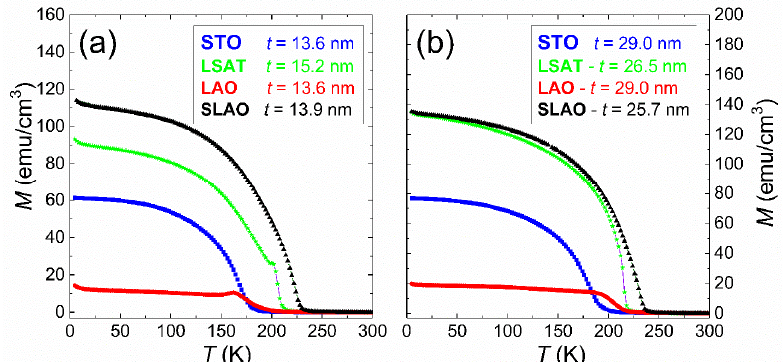
Figure 5. Field-cooled magnetization curves under in-plane magnetic field of 100 Oe performed on LSCO films grown on STO, LSAT, LAO, and SLAO substrates for two representative thicknesses, around 14 nm ( a ) and 28 nm ( b ).